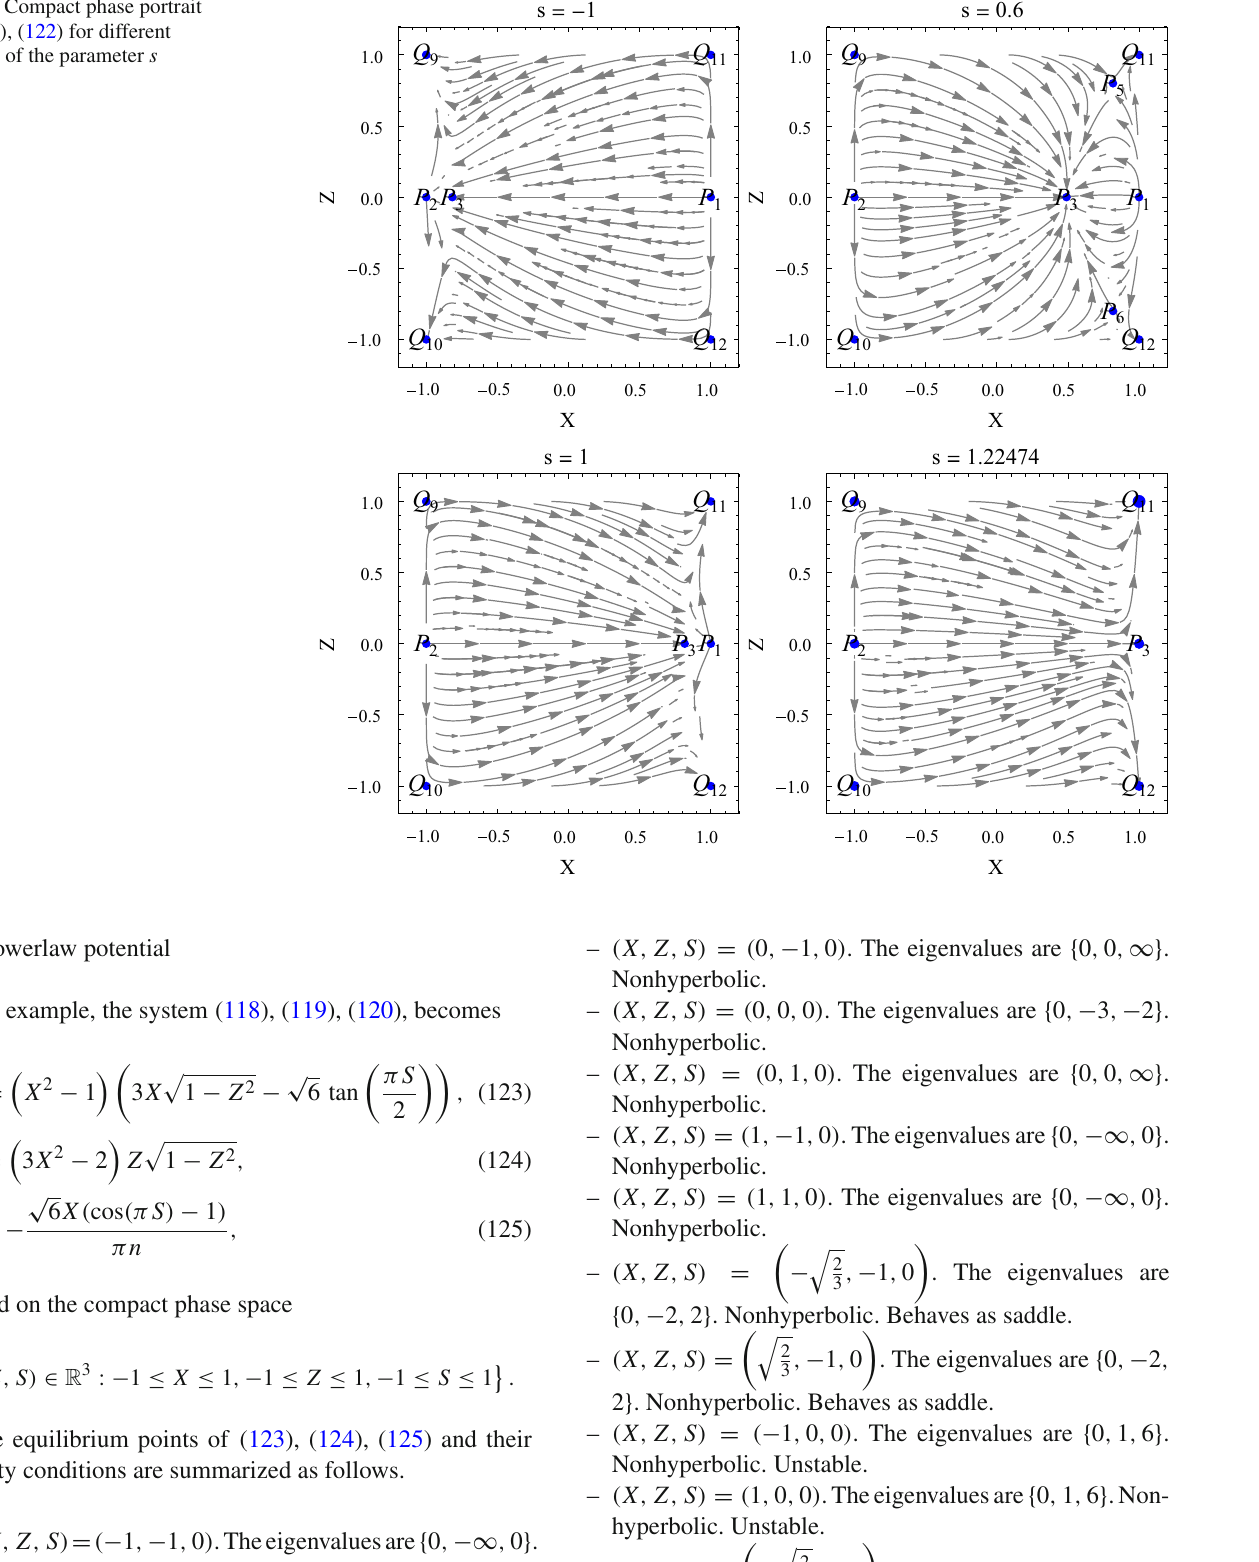
Fig. 4 Compact phase portrait of (121), (122) for different choices of the parameter